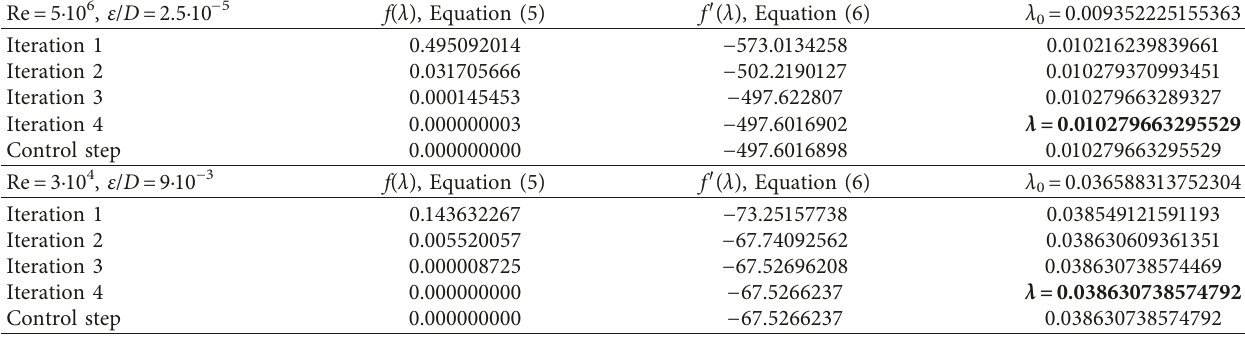
Table 1: Newton–Raphson procedure. Option 1: starting point λ and analytical derivative f ′ ( λ ): Equation (6).